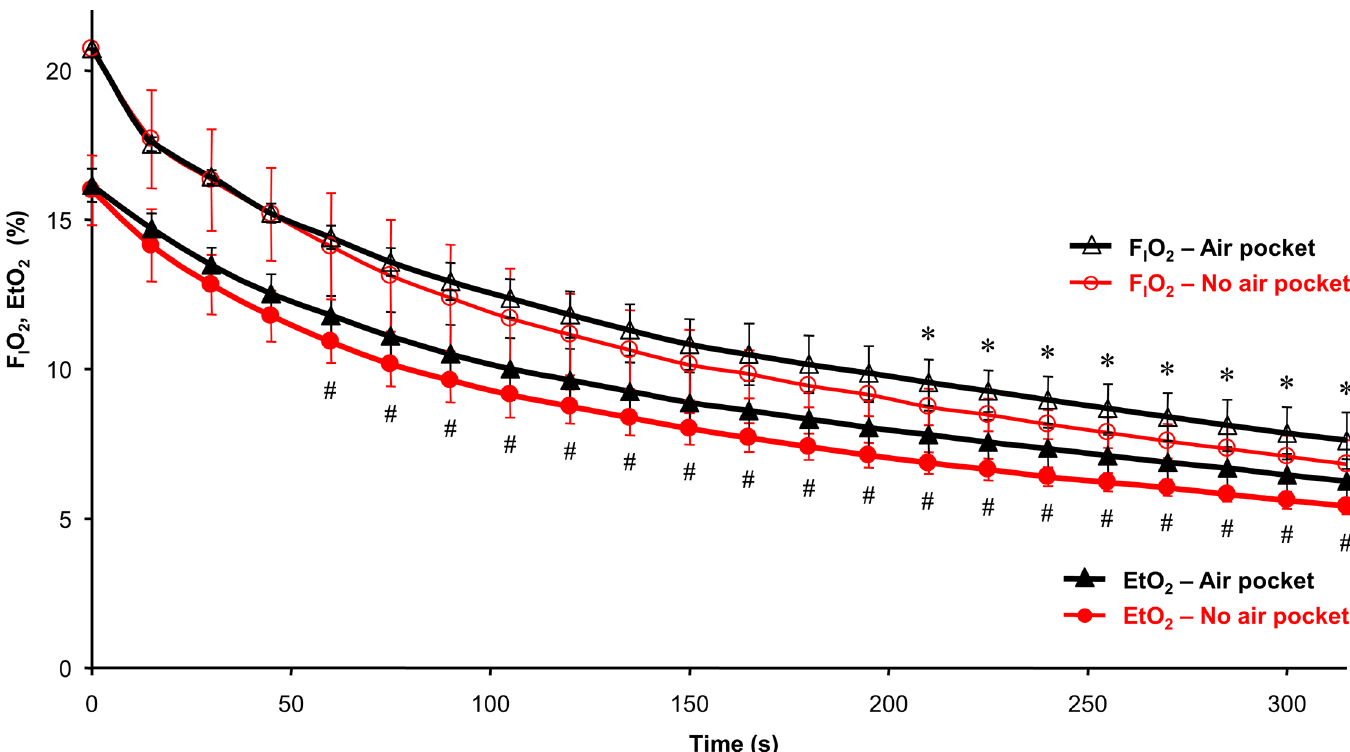
Fig 5. Inspiratory (F I O 2 ) and end-tidal (EtO 2 ) fractions of oxygen in the breathing gas during NP and AP phases. The symbol * represents statistically significant differences in F I O 2 between NP and AP groups; the symbol # represents statistically significant differences in EtO 2 between NP and AP phases; p (cid:1) 0.05.